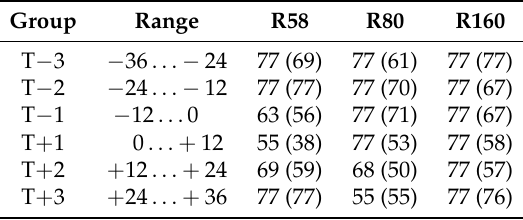
Table 3. Time groups used in the time separation analysis. The range defines days before the mowing event ( − ) or after the event ( + ). The R58, R80, and R160 columns contain the number of samples for each group and their respective geometries. The number of samples after precipitation filtering is also given in parenthesis. Group Range